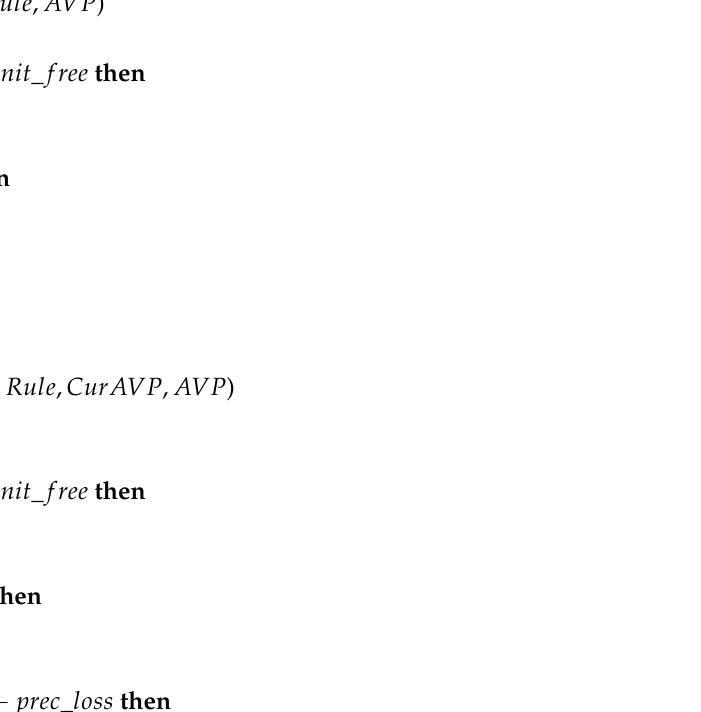
Algorithm 3 Two auxiliary functions for ChooseNext heuristic. function I S C HOSEN ( Collection , Rule , AVP